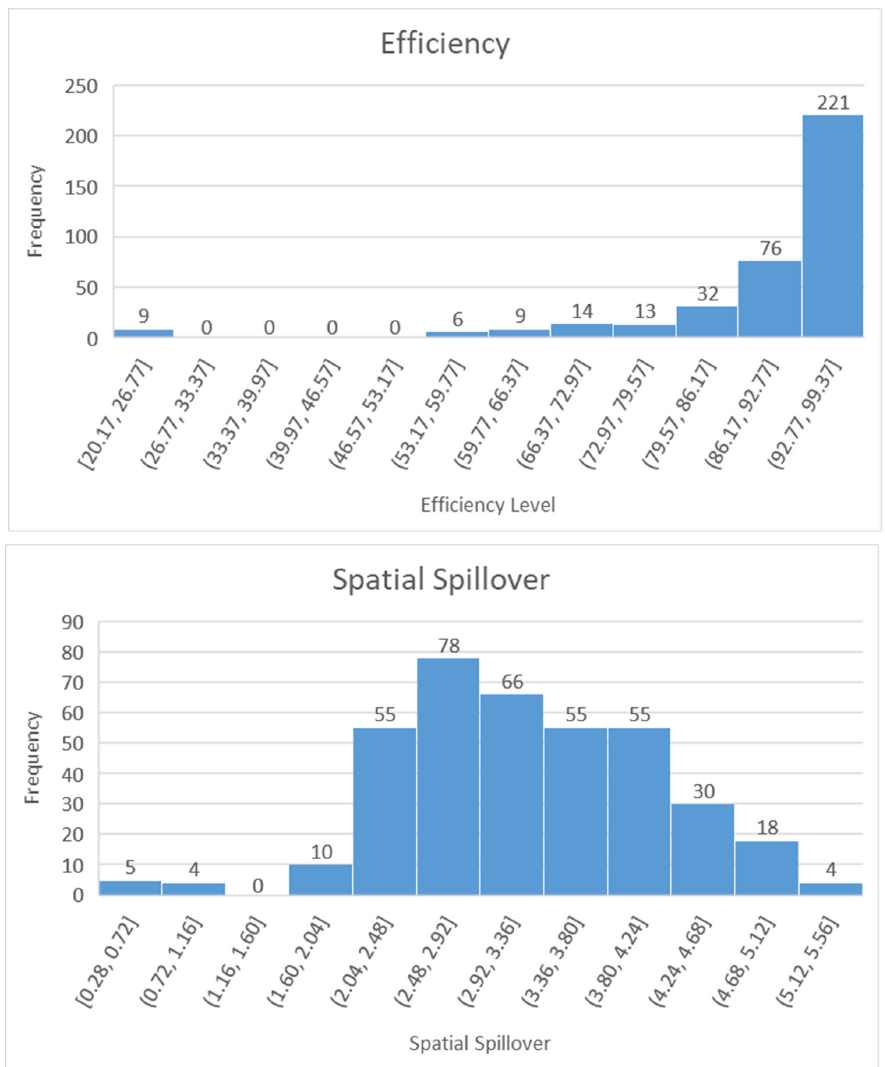
Figure 3. Efficiency and Spatial Spillover distribution.